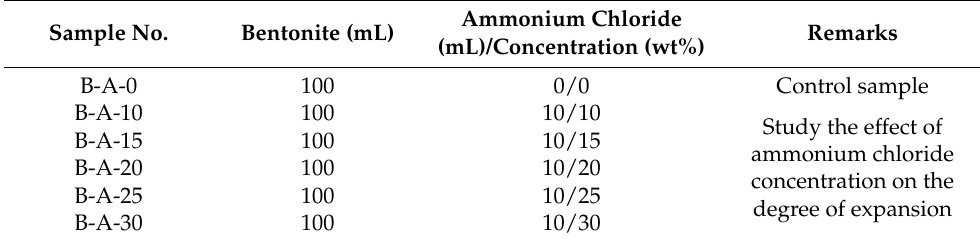
Table 5. B/A modified slurries modifier